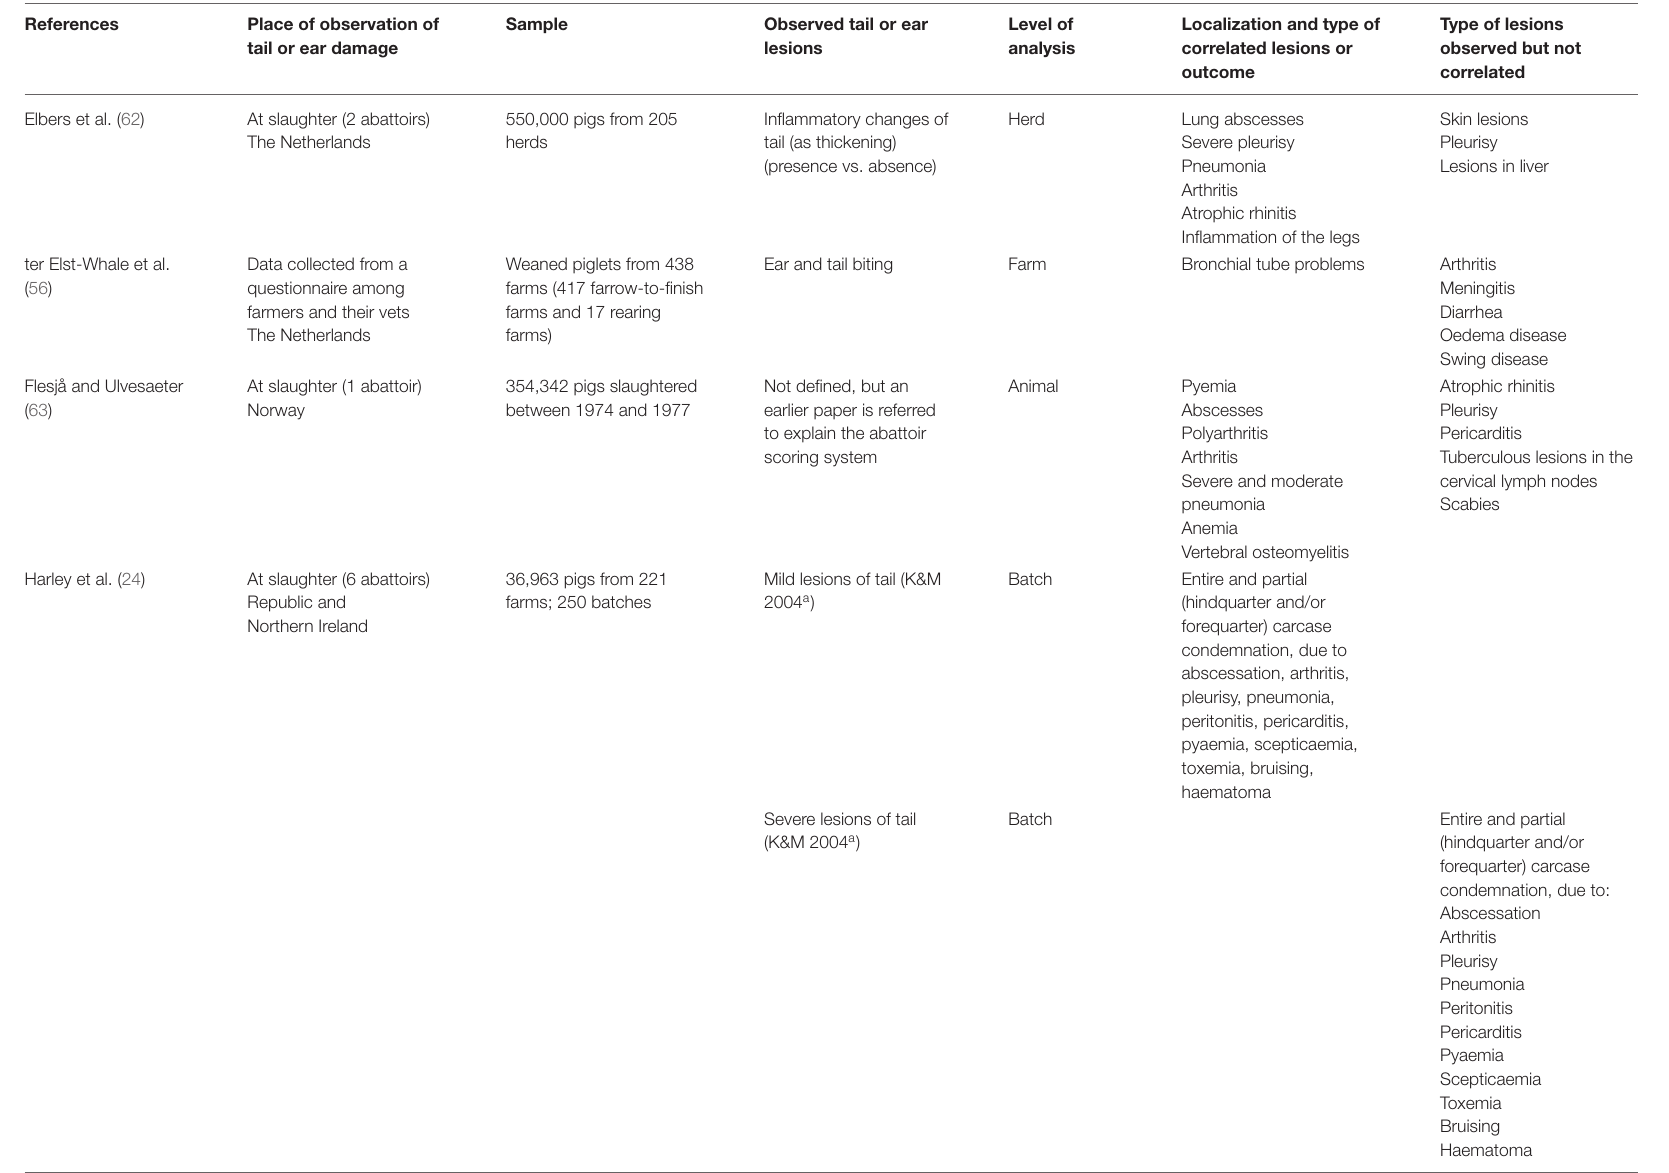
TABLE 1 | Overview of studies showing correlations between tail and ear lesions on farm or at slaughter and carcass findings at